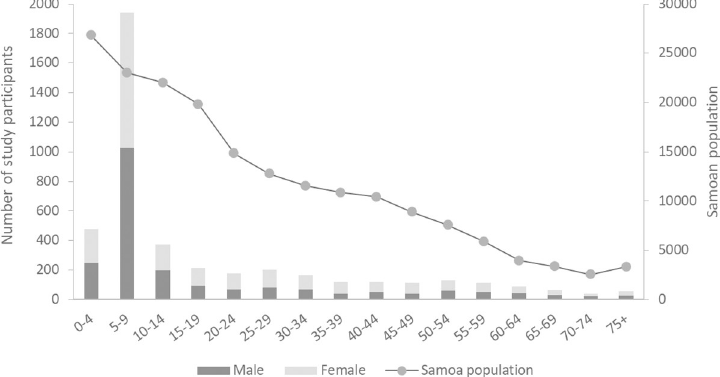
Fig 2. Age distribution of study participants (primary axis) and Samoan population (2011 census) (secondary axis).